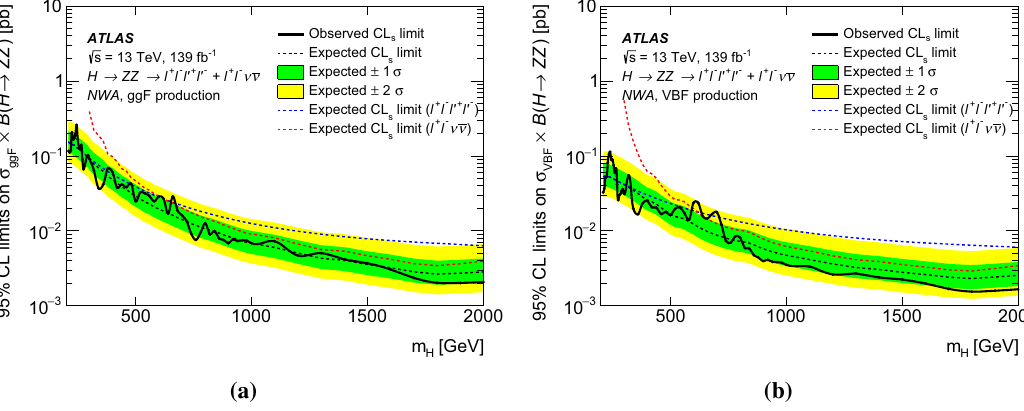
(cid:3) + (cid:3) − (cid:3) (cid:2)+ (cid:3) (cid:2)− state the cut-based categorisation is used. The green and yellow bands represent the ± 1 σ and ± 2 σ uncertainties in the expected limits. The dashed coloured lines indicate the expected limits obtained from the individual